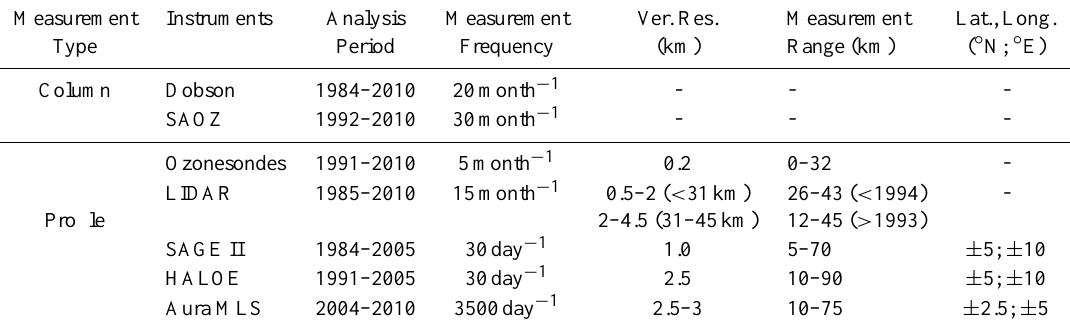
Table 2. The regression coefficients of QBO 10, QBO 30, solar flux (SFX), NAO, heat flux (HFX) and volcanic aerosols estimated from the total column ozone measurements, shown for April, November and the average of all months. The QBO 10 and QBO 30 are ex-